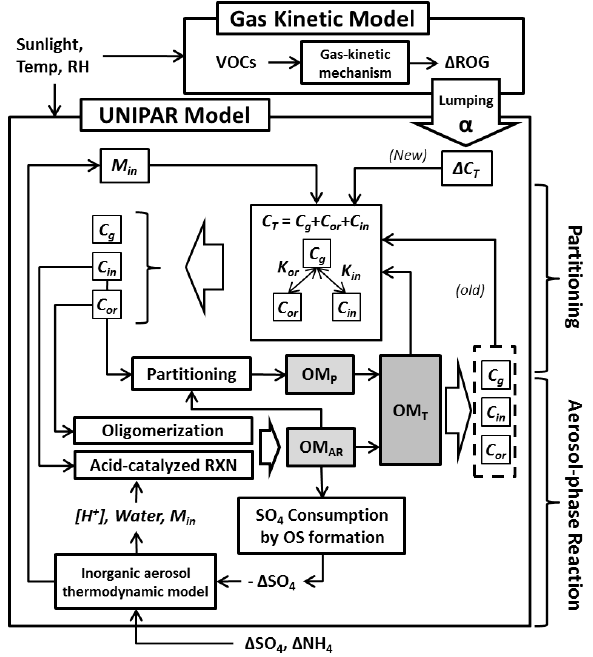
Fig. 2. Computational flow of the UNIPAR model. 1ROG is the reacted organic parent compound during 1t , and α i,j is the mass- based stoichiometric coefficient. C and K represent the concentra- tion of lumping species and partitioning coefficient, respectively, and the subscription of “g”, “or”, and “in” denote gas, organic, and inorganic aerosol phases, respectively. OM P , and OM AR are the concentrations of organic matter produced by partitioning and aerosol-phase reactions, respectively. M in is the concentration of inorganic